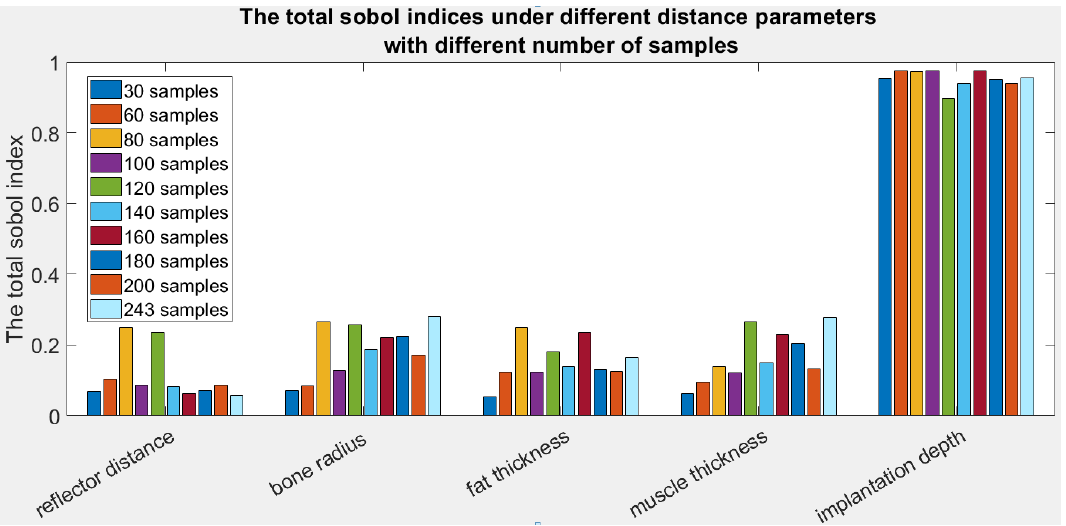
ff erent parameters under di ff erent number of Figure 5. The Sobol indices VS different parameters under different number of samples. Figure 5. The Sobol indices VS di